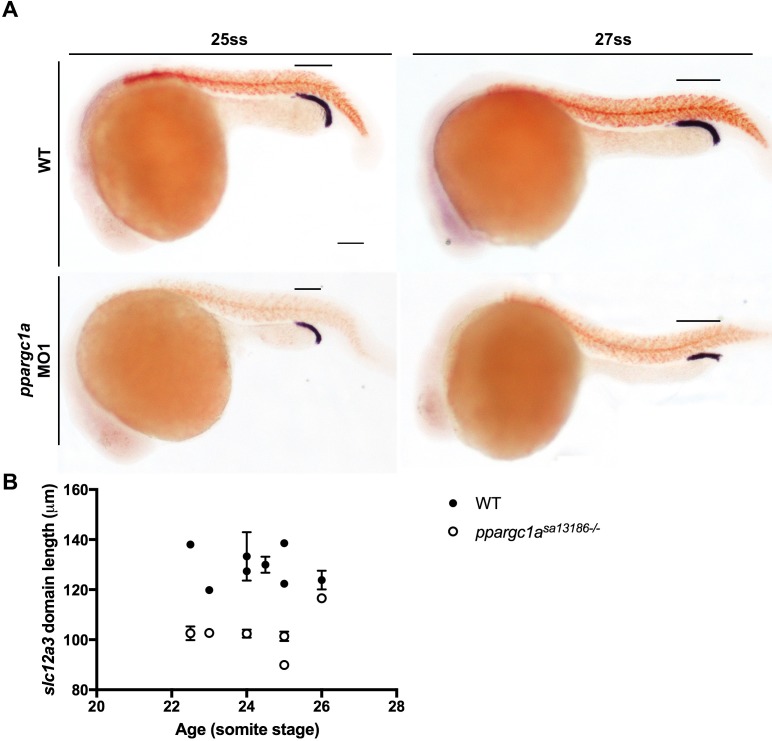
Decreased DL phenotypes are evident at the 25 ss and 27 ss in ppargc1a-deficient embryos.(A) Double WISH for slc12a3 (purple) and smyhc (red) in WT and ppargc1a MO1 injected zebrafish. Scale bars = 100 μm. (B) Graph indicating the slc12a3 domain length in relation to age (in ss) in WT (black) and MO1 injected (white).